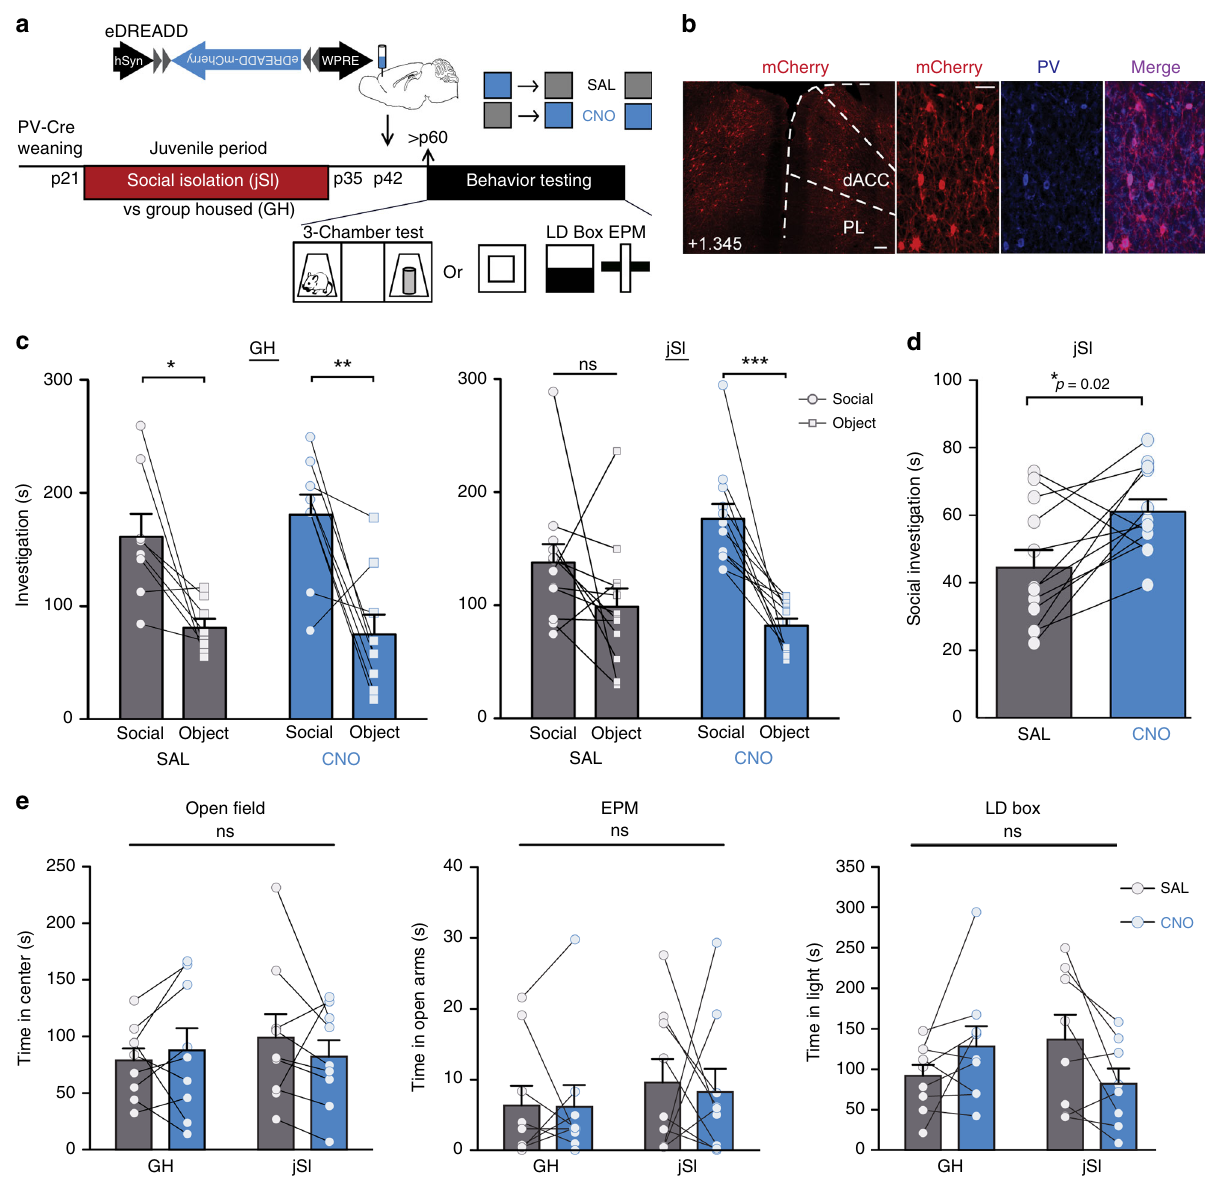
Fig. 6 Chemogenetic activation of adult dmPFC-PVIs mitigates social de fi cits induced by juvenile isolation. a Timeline showing juvenile social isolation (jSI), Cre-dependent excitatory DREADD (eDREADD) viral injection (p42) in PV-Cre mice, and sociability and anxiety behavior testing (adult, p60 – 80). b Immunohistochemistry validation of co-localization between mCherry (eDREADD, red) and parvalbumin (PV) antibody (blue). Scale bar left = 100 μ m. Scale bar right = 50 μ m. c Full behavioral results from the 3-chamber test for sociability show that jSI mice treated with SAL do not show a social preference; however, mice treated with CNO show a signi fi cant social preference. GH mice show a signi fi cant social preference under both SAL and CNO conditions (two-way repeated measures ANOVA, GH: drug x stimulus interaction F(1,7) = 0.13, p = 0.73 jSI: drug x stimulus interaction, F(1,11) = 6.28, *p